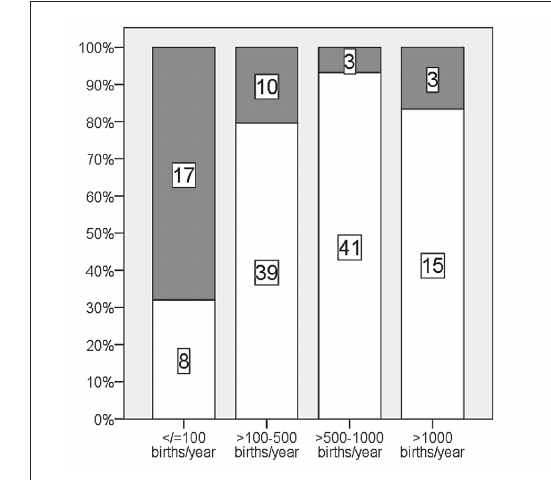
Screening rate by size of maternity unit (n = 136). Percent- age (indexed on the left) of units with regular PO screening (white) and without (grey). Size is categorised as very small (<=100 births/year; n = 25), small (>100–500 births/year; n = 49), medium-sized (>500–1000 births/year; n = 44), and large (>1000 births/year; n =